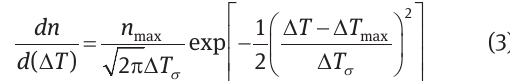
function, dn / d ( D T ), is used to describe the grain den- sity change, dn is induced by increase of the undercool- ing, d ( D T ). The distribution function is expressed by